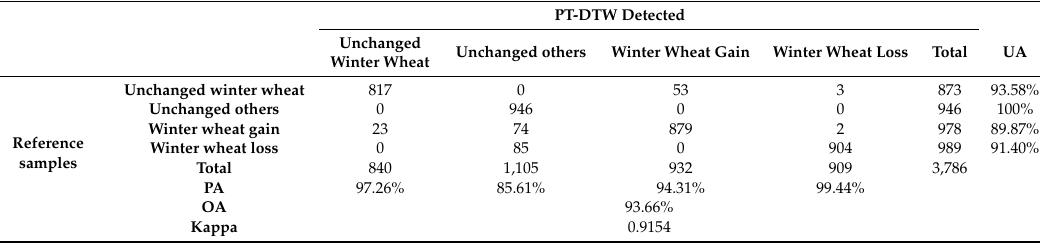
Figure 15. Sentinel-2 RGB images acquired on 24 December 2017 and 09 December 2018, PT-DTW-derived winter wheat maps of 2017–2018 and 2018–2019, and changes of winter wheat planting in the area covered by tile 50SLH of Sentinel-2 images. Table 4. Winter wheat change detection accuracy assessment. Expressed in number of